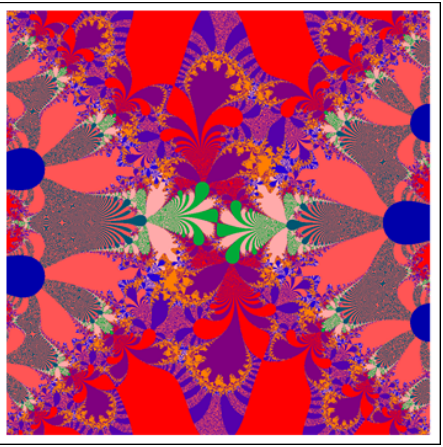
Figure 20. J-set via F-iterative scheme for e z 2 + ( − 0.1 i ) with image visual time = 69.3